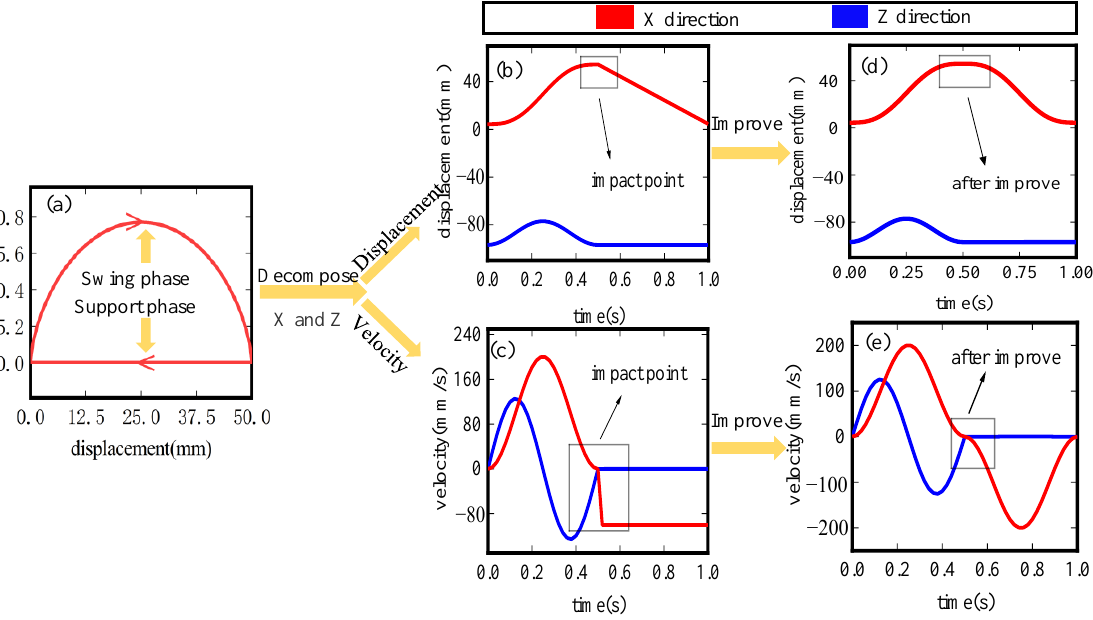
Figure 2. Schematic diagram of motion curve decomposition and optimization of quadruped robot, ( a ) zero-impact foot trajectories in the swing and support phases, ( b ) zero-impact displacement trajectory before the improvement, ( c ) zero-impact velocity trajectory before the improvement, ( d ) zero-impact displacement trajectory after the improvement, and ( e ) zero-impact velocity trajectory after the improvement.